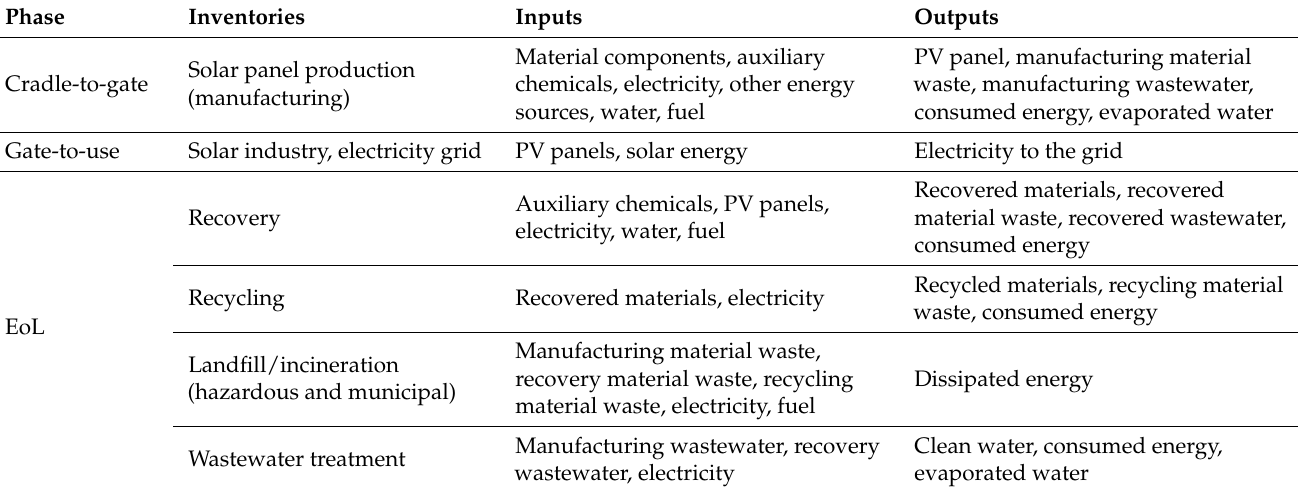
Table 1. Life cycle assessment phases for s-Si and CdTe PV panels, including cradle-to-gate, gate-to- use, EoL, and their corresponding inventories, inputs, and outputs integrated for MEW